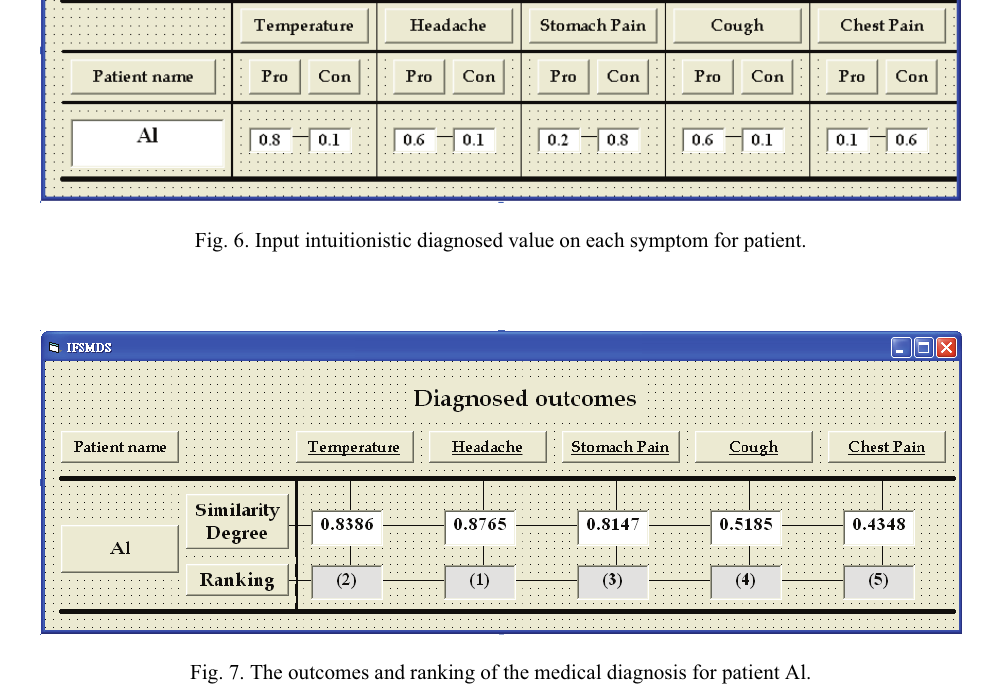
Fig. 7. The outcomes and ranking of the medical diagnosis for patient